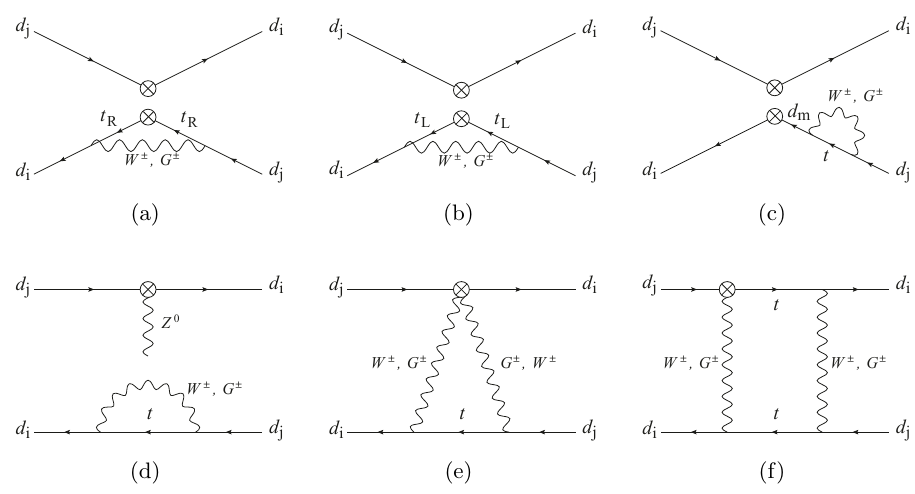
Figure 1 . Feynman diagrams for the one-loop matchings onto the (cid:1) F = 2 operators ( i 6 = j ). RGEs are solved at the one-loop level. The SMEFT RGEs relevant to the (cid:1) F = 2 observ- ables are listed in appendix A. We keep the anomalous dimension terms which depend on the top Yukawa or QCD